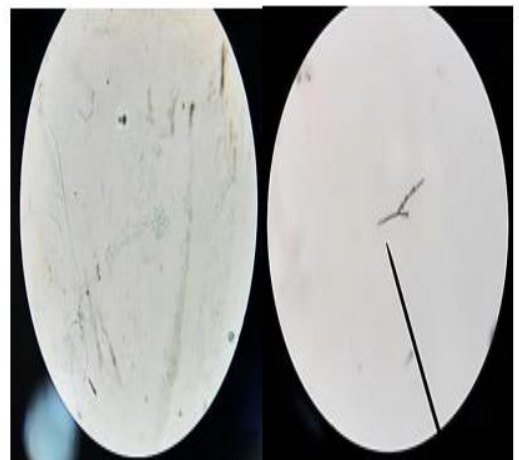
Figure 1. 10% KOH wet mount examination shows fungal